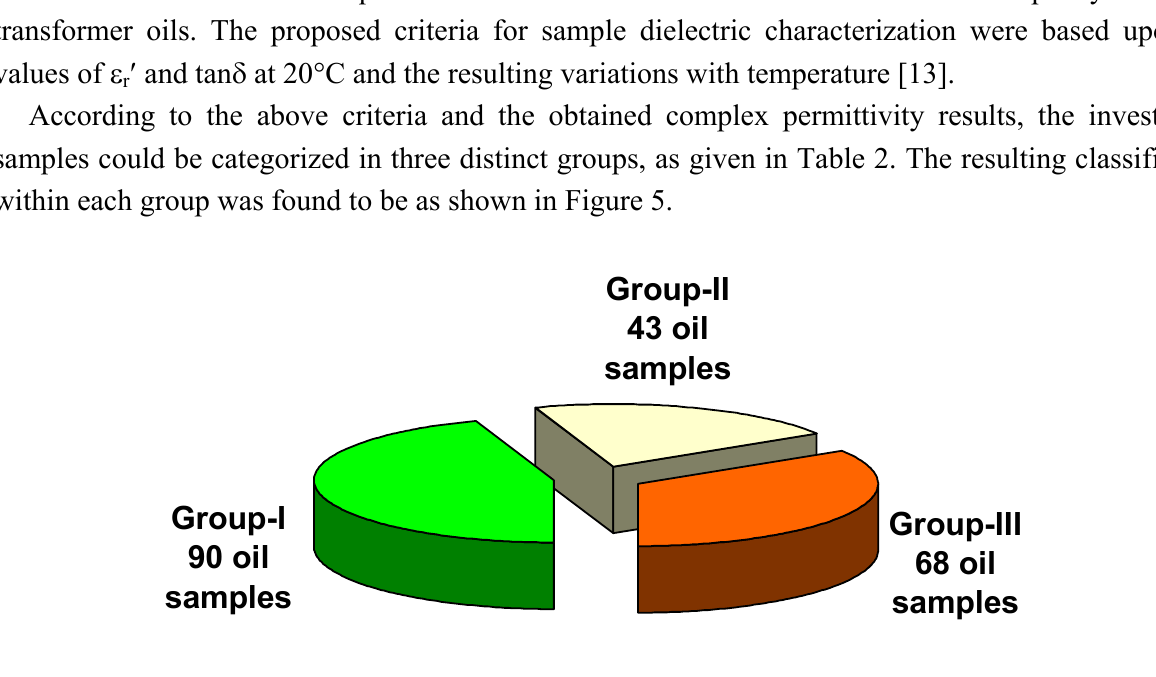
Figure 5. Number of oil samples characterized within each